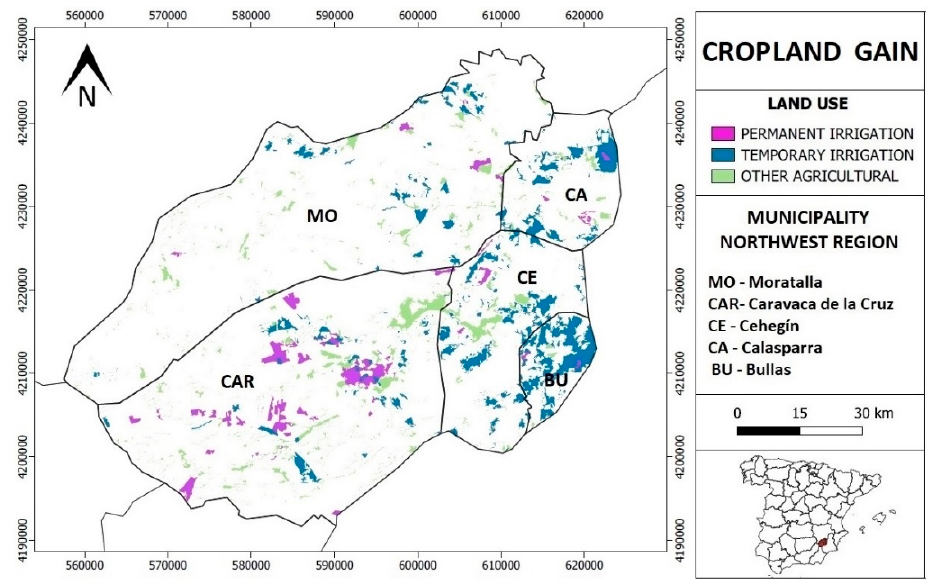
Figure 10. Gains from cultivated areas as a function of agricultural use (1990–2018). Source: Authors.